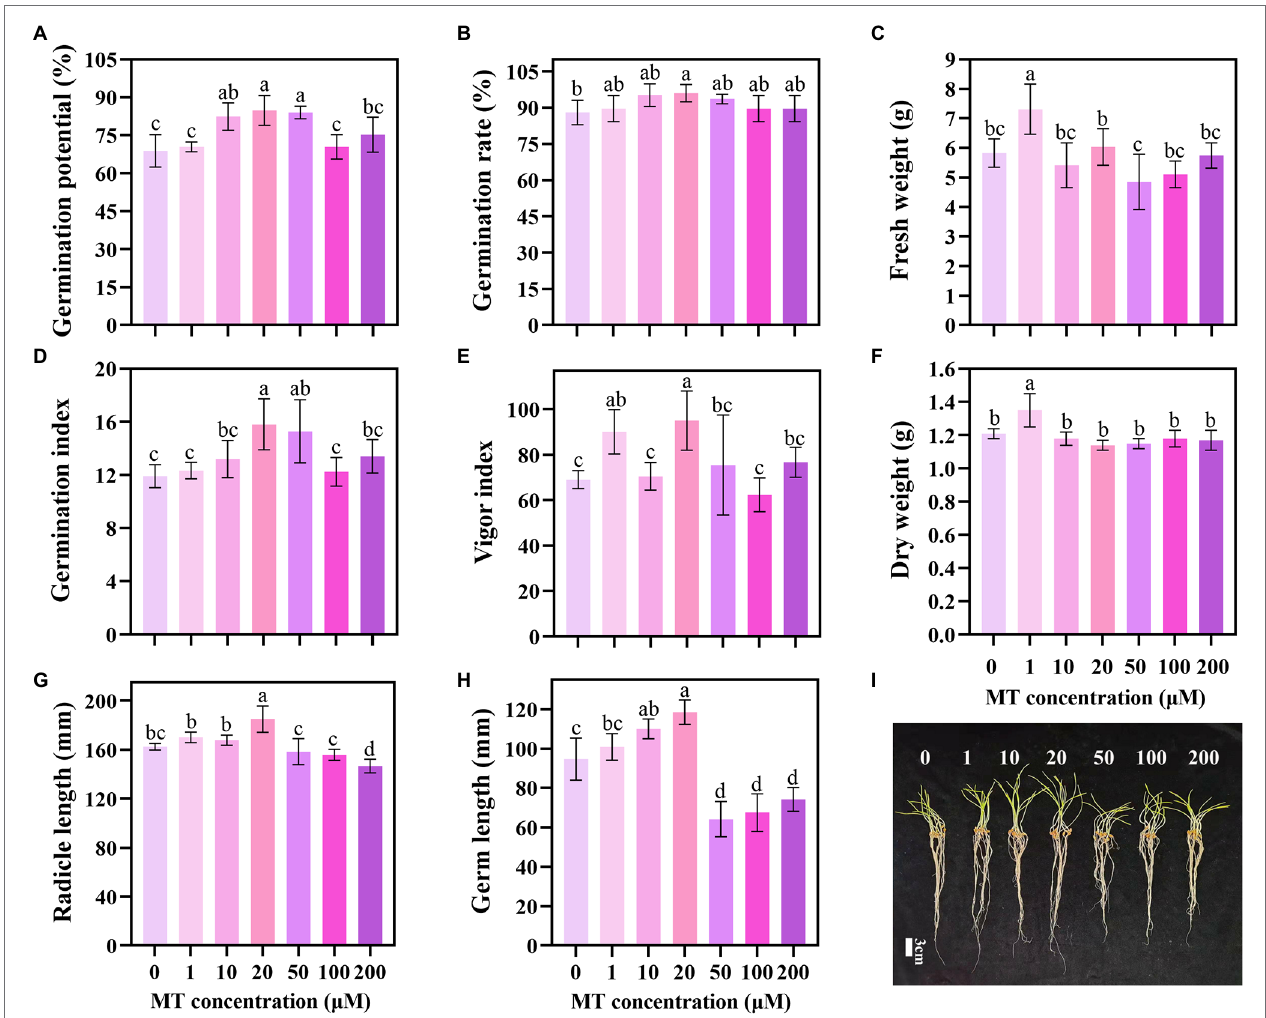
FIGURE 1 | Germination characteristics of triticale seeds following treatment with different MT concentrations under drought stress. (A) Germination potential (GP), (B) germination rate (GR), (C) fresh weight, (D) germination index (GI), (E) vigor index (VI), (F) dry weight, (G) radicle length, (H) germ length, and (I) germination of MT primed triticale seeds after 7 days. Both (G,H) values are the means of 10 replicates ± standard error, while other data are the means of five replicates ± standard error. For each trait, bars with the same letter are not significantly different at p < 0.05. Different lower letters indicate significant differences among the treatments ( p <